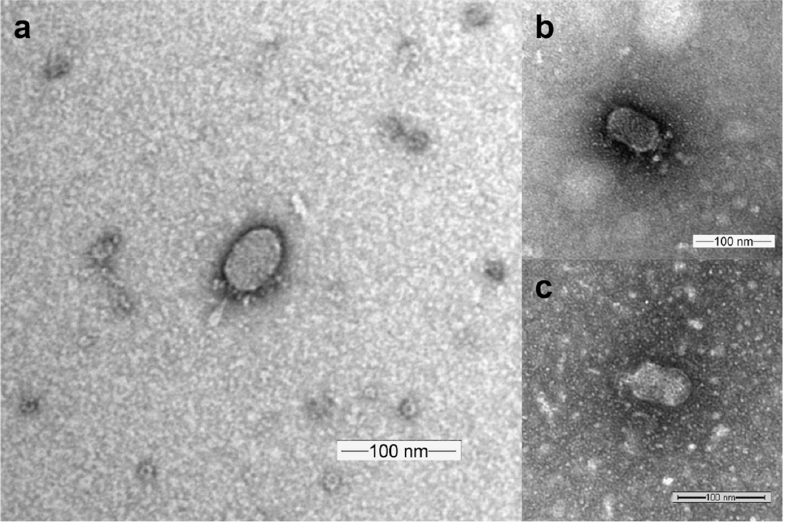
Figure 1 . Representative transmission electron microscopy images for SerPounce ( a ), Beachbum ( b ) and Harambe ( c ).